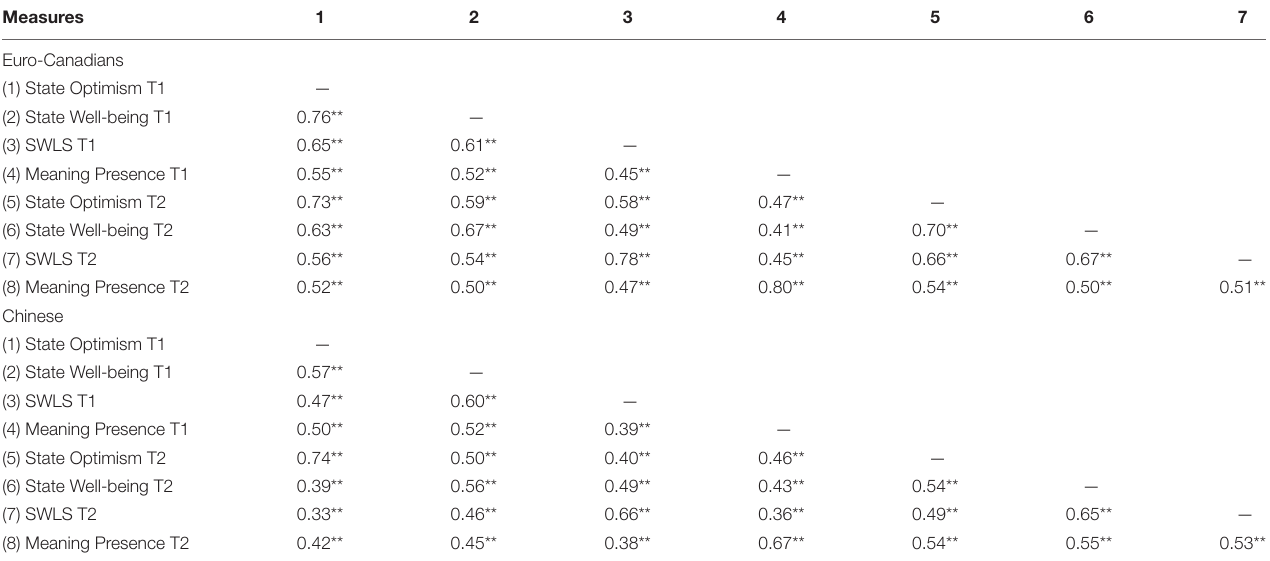
TABLE 1 | Correlation among main